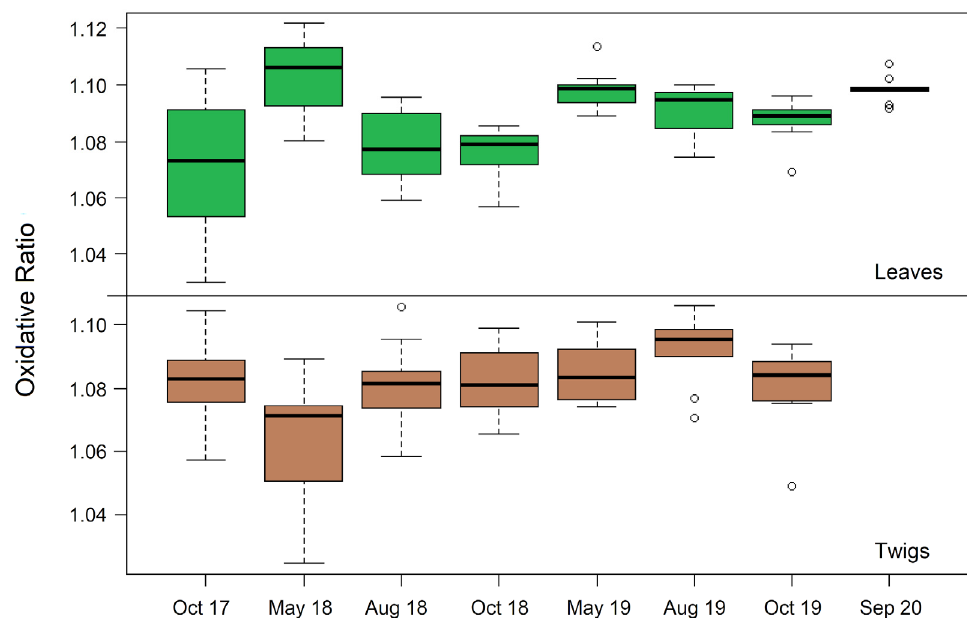
Figure 5. Boxplots of leaf (green) and twig (brown) oxidative ratios, separated by sampling